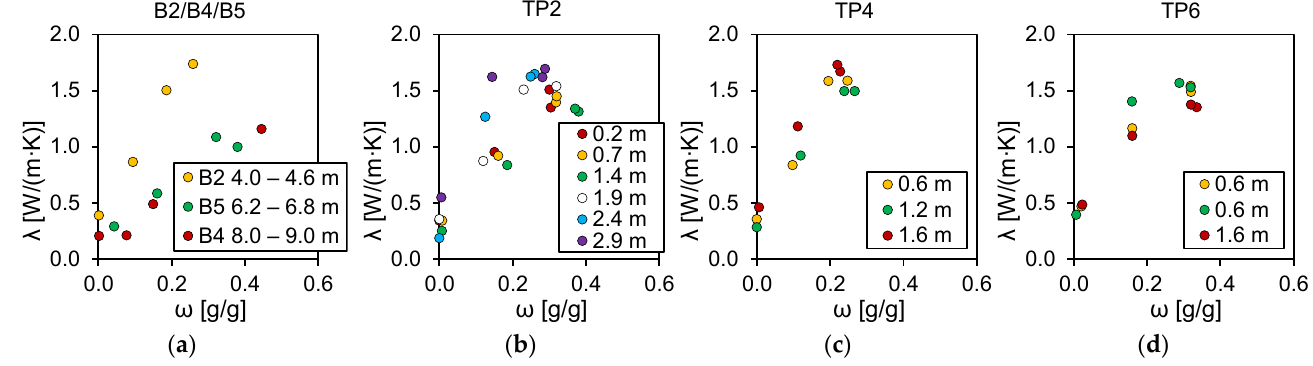
Figure 4. Results of thermal conductivity ( λ ) measurements as a function of the gravimetric water content ( ω ) using the punctual method for samples of ( a ) B2, B4 and B5, ( b ) TP2, ( c ) TP4 and ( d ) TP6. Here, predominantly increasing thermal conductivities occurred with increasing ω .